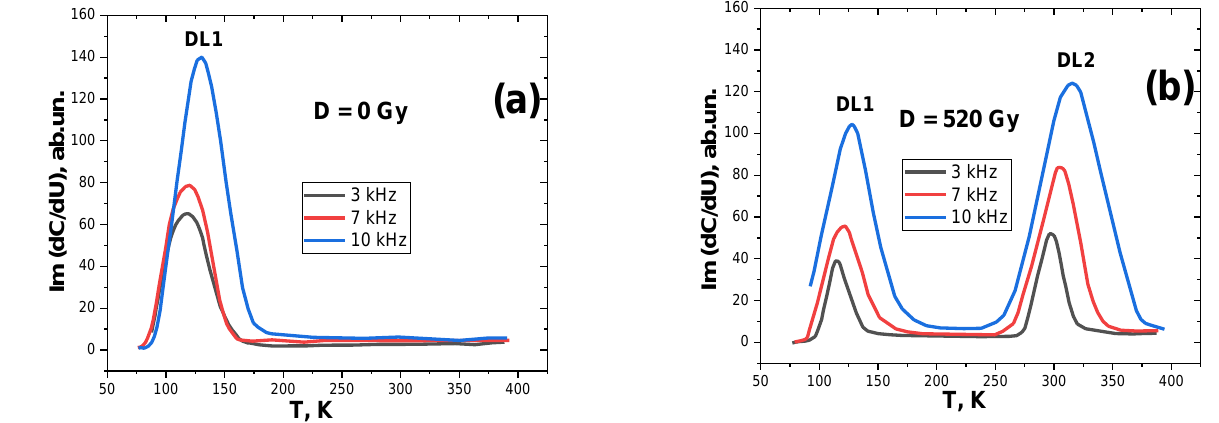
Figure 5. Capacitive-modulation spectrum of deep levels in the band gap of the Bi-Si-Al surface barrier structures before ( a ) and after ( b ) X-irradiation with dose D = 520 Gy.